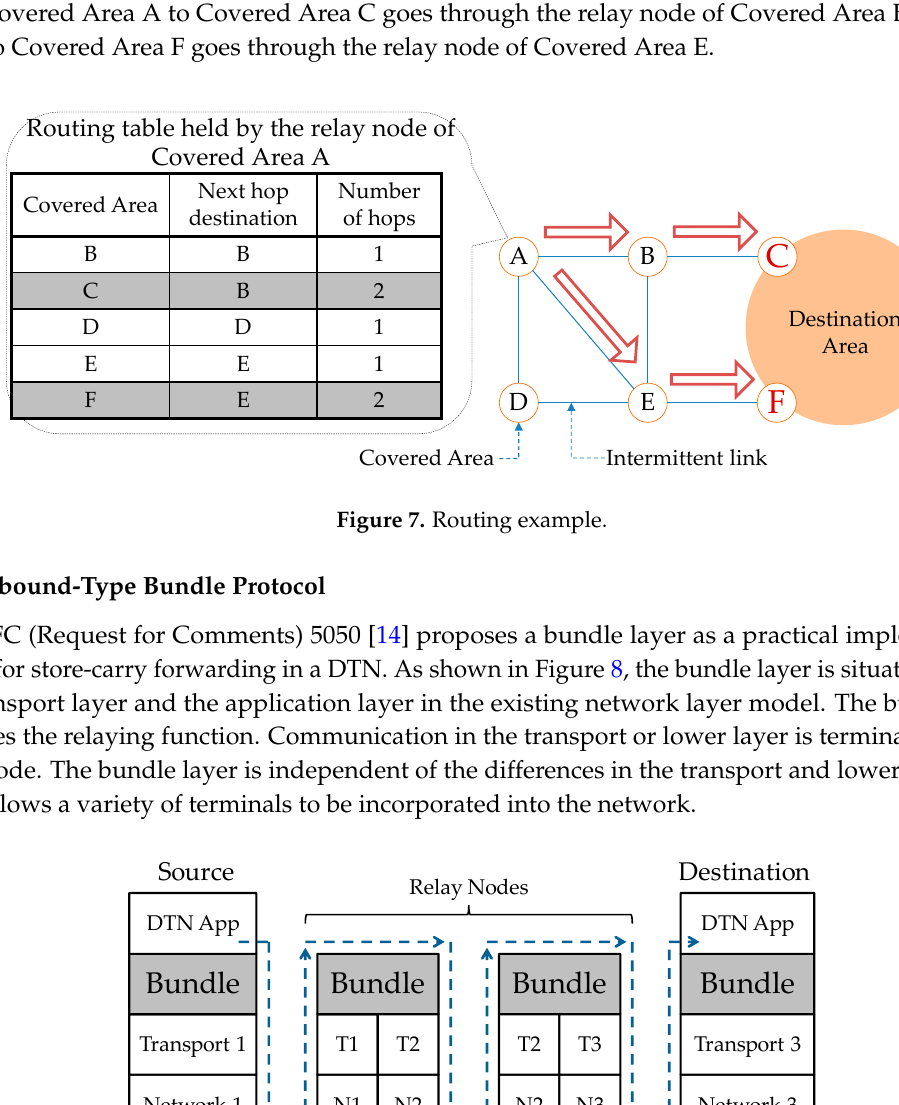
Figure 6. Layout example of the destination area and covered areas.